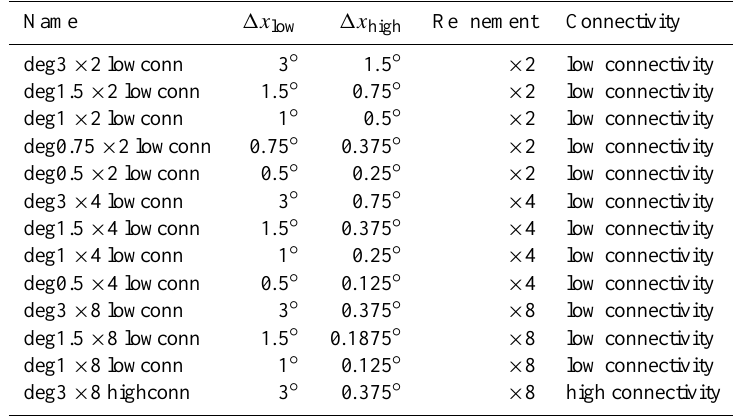
Table 1. Summary of the × 2, × 4, and × 8 family of grids.